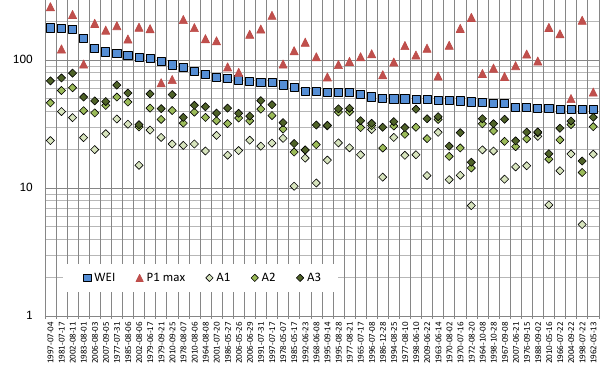
Figure 9. EPEs characterized by the WEI, maximum daily precip- itation total [mm] at a site ( P 1 ), and areal mean precipitation total [mm] in the Czech Republic recorded during 1 day ( A 1 ), 2 days ( A 2 ), and 3 days ( A 3